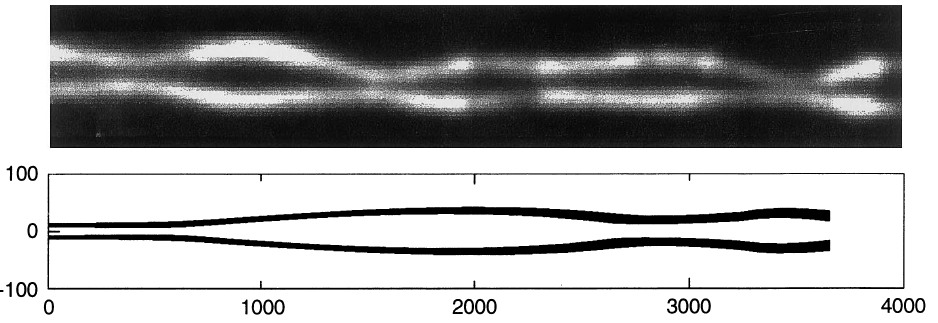
Fig. 4. Engine jet trajectory be- hind a typical large aircraft. This calculation is carried out using the integral model. Qualitative comparison with a contrail pho- tograph